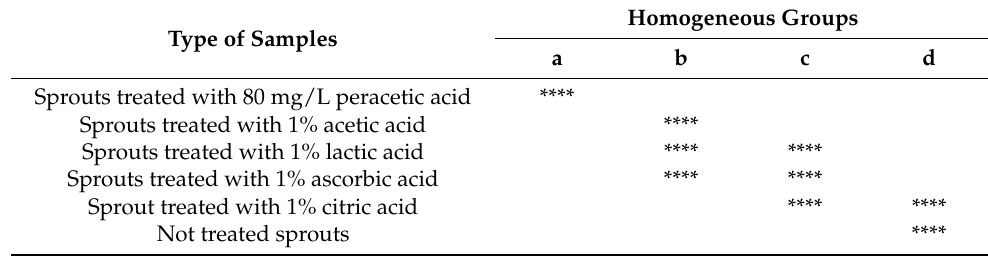
Table 9. Group homogeneity test ( α = 0.05) comparing the effect of the organic acids used on the ∆ E* values of red cabbage sprouts subjected to 14-day storage.